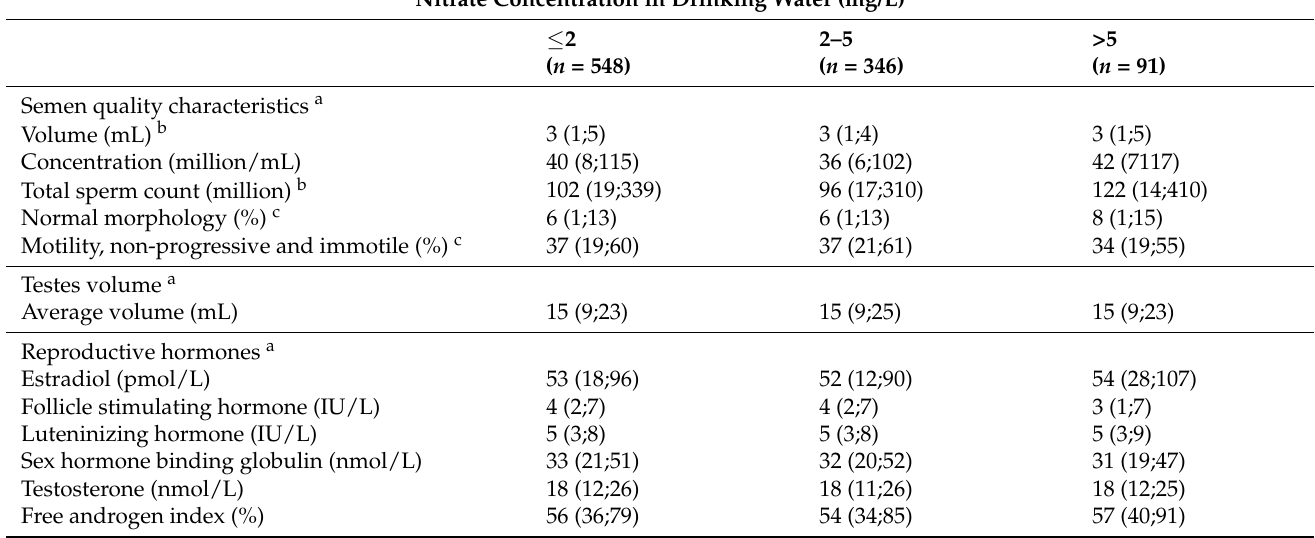
Table 2. Baseline information on reproductive outcomes according to nitrate concentration in mater- nal drinking